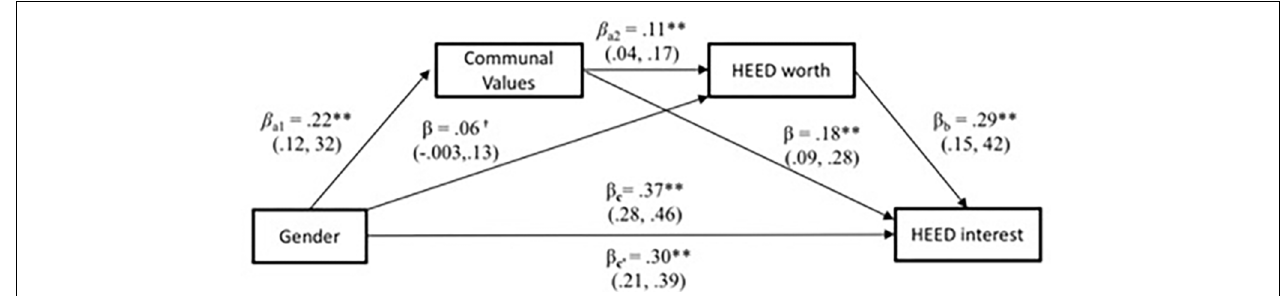
FIGURE 3 | Serial mediation model for HEED variables in Study 1. ∗∗ p < 0.01, ∗ p < 0.05, † p < 0.10. All paths control for agentic values, interest in STEM, and societal worth of STEM.